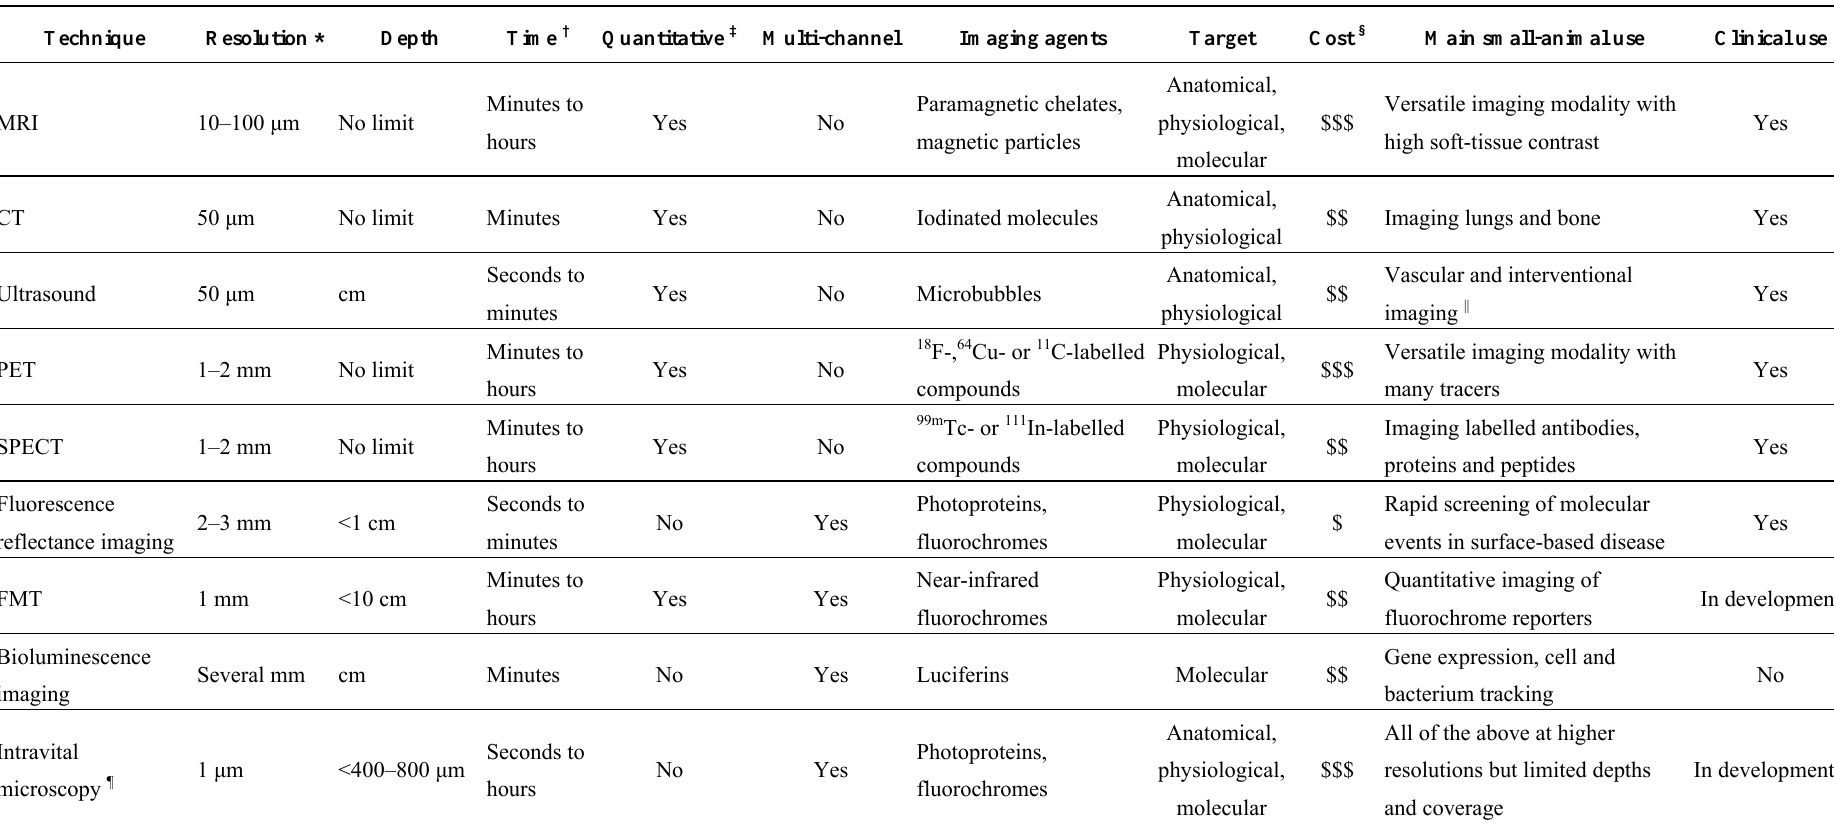
Table 1. Overview of imaging systems. Reproduced with permission from [9]. Copyright 2008 Nature Publishing